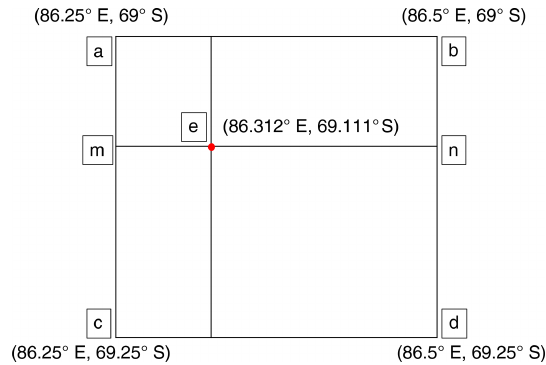
Figure A4. The location of the MBS Main ice core site (e) and the four nearby ERA5 pixels (a, b, c, d) . The weighted average of the (a) and (c) , shown by (m) , and that of (b) and (d) , shown by (n) , were used to calculate the weighted average for the MBS Main